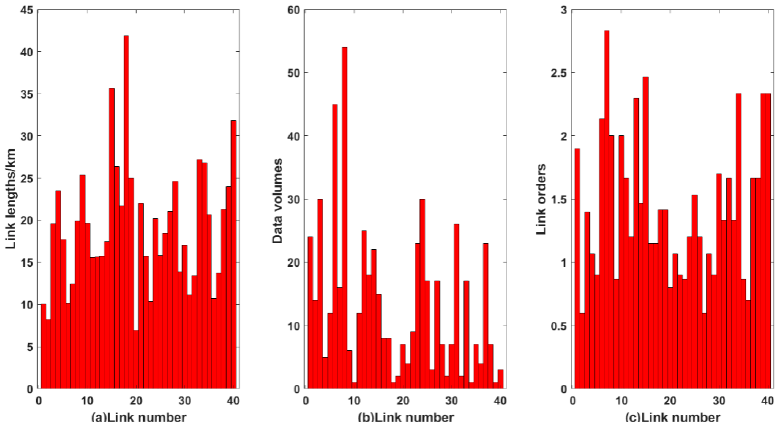
Figure 4. The relations of ( a ) link lengths, ( b ) data volumes, and ( c ) link orders with different link number.